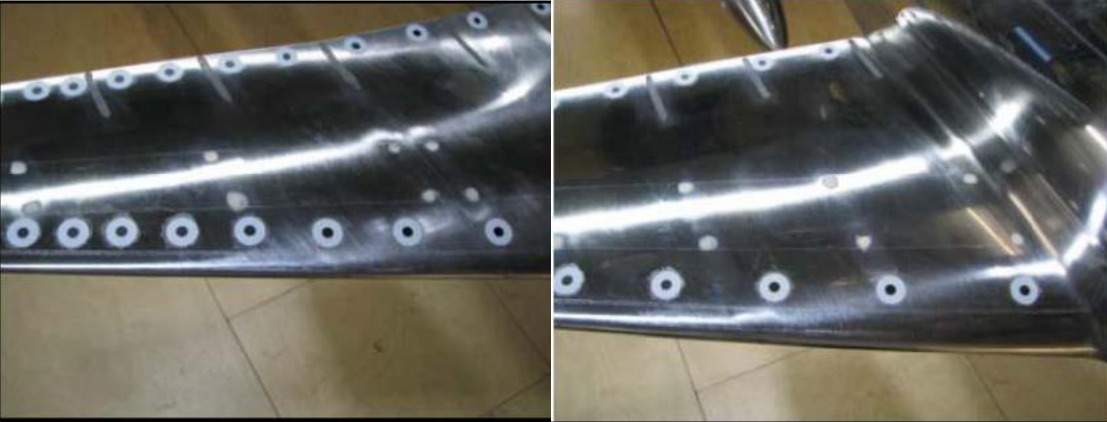
Figure 3. SPT markers on the supercritical wing.